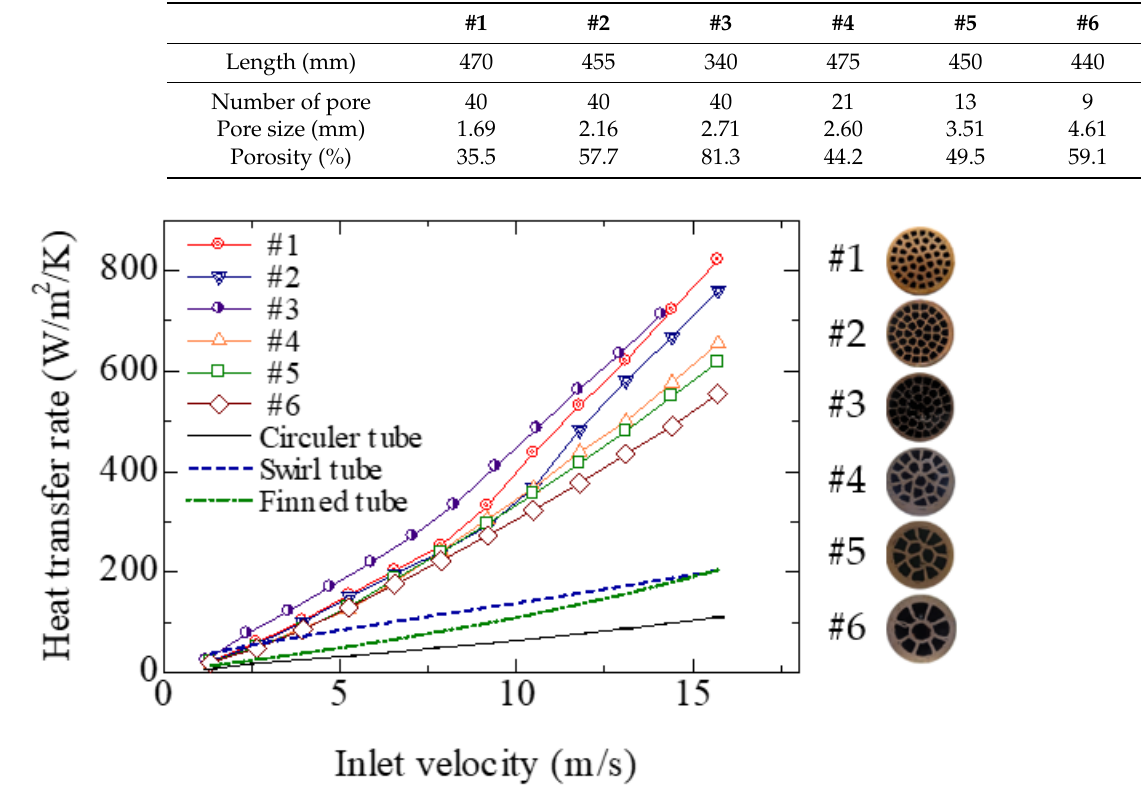
Figure 5. Heat transfer performance of porous tubes.